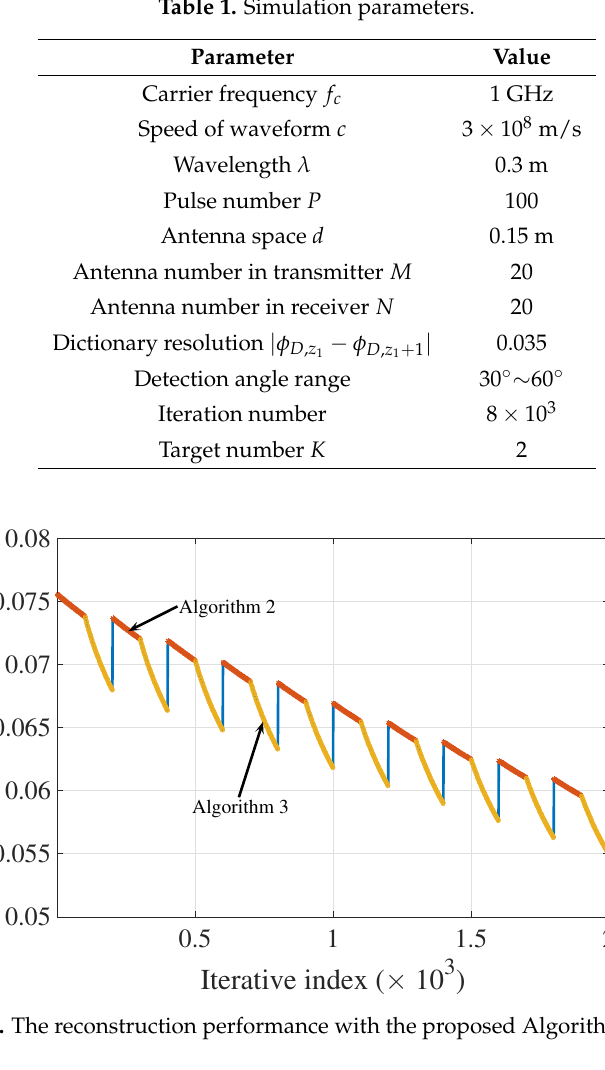
Table 1. Simulation parameters.